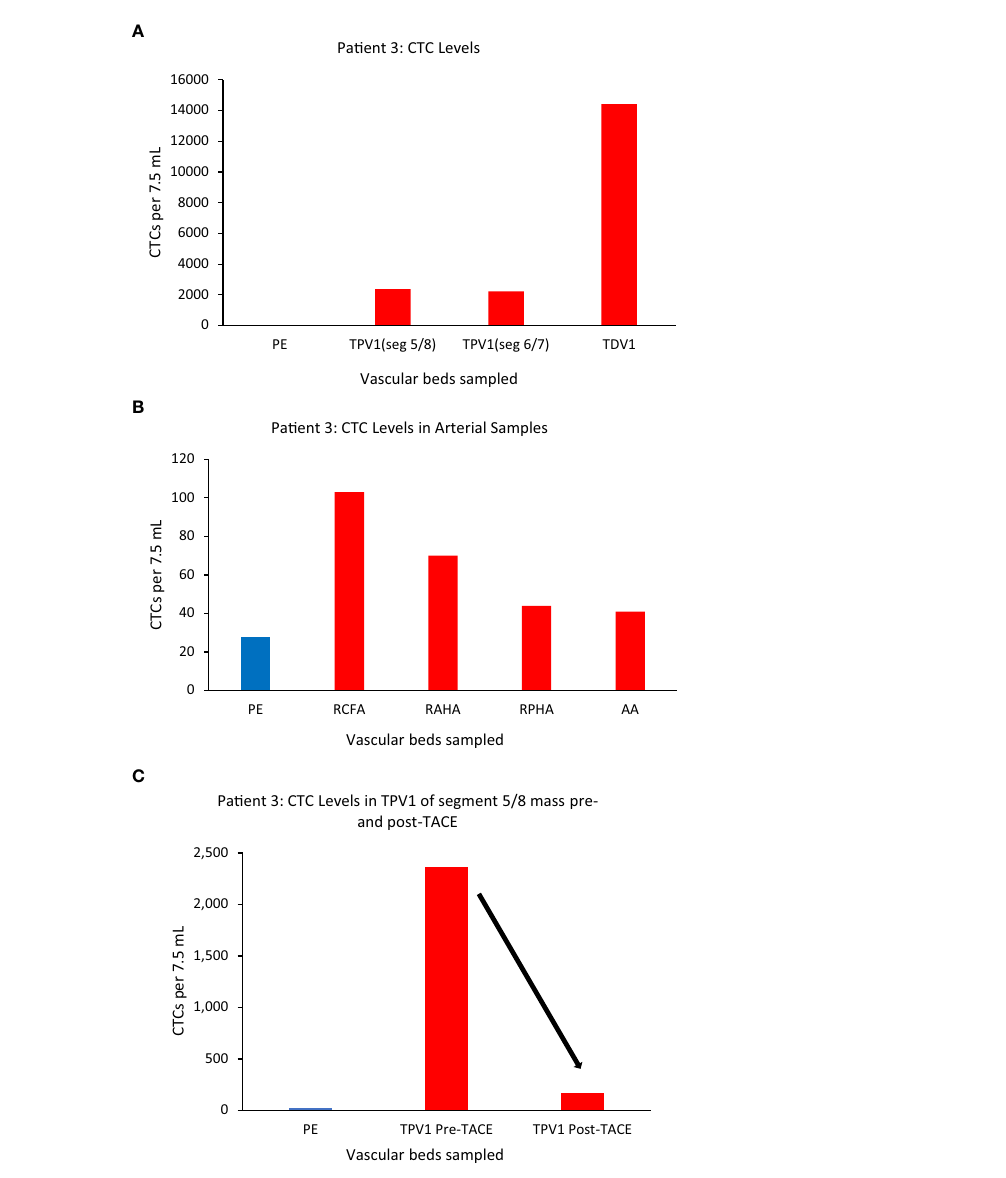
FIGURE 5 CTC levels in the tumor-draining and peripheral veins of patient 3. A small branch of the accessory right hepatic vein (ARHV) close to the tumor was considered as TDV1 for the segment 5/8 mass, the middle hepatic vein (MHV) as TPV1 of the segment 5/8 mass, and an inferior branch of the ARHV as the TPV1of segment 6/7 mass. Panel (A) shows CTC levels were: 2364 in the TPV1 of the segment 5/8 mass, 2213 in the TPV1 of the segment 6/7 mass, and 14412 in the TDV1 (TDV and TPVs in red) compared to peripheral sample (PE, in blue). Panel (B) shows CTC values in various arterial vascular beds with substantially less CTC enrichment in contrast to venous sampling downstream of liver tumors via the hepatic veins as noted in (A) . Right common femoral artery (RCFA), right anterior hepatic artery (RAHA), right posterior hepatic artery (RPHA) and the aortic arch (AA) are in red and peripheral vein sample (PE) is in blue. Panel (C) shows a reduction in CTC levels in the TPV1 of the segment 5/8 mass after trans-arterial chemoembolization (TACE) of this mass from 2364 (pre-TACE) to 173 (post-TACE). All CTC values are per 7.5 ml of